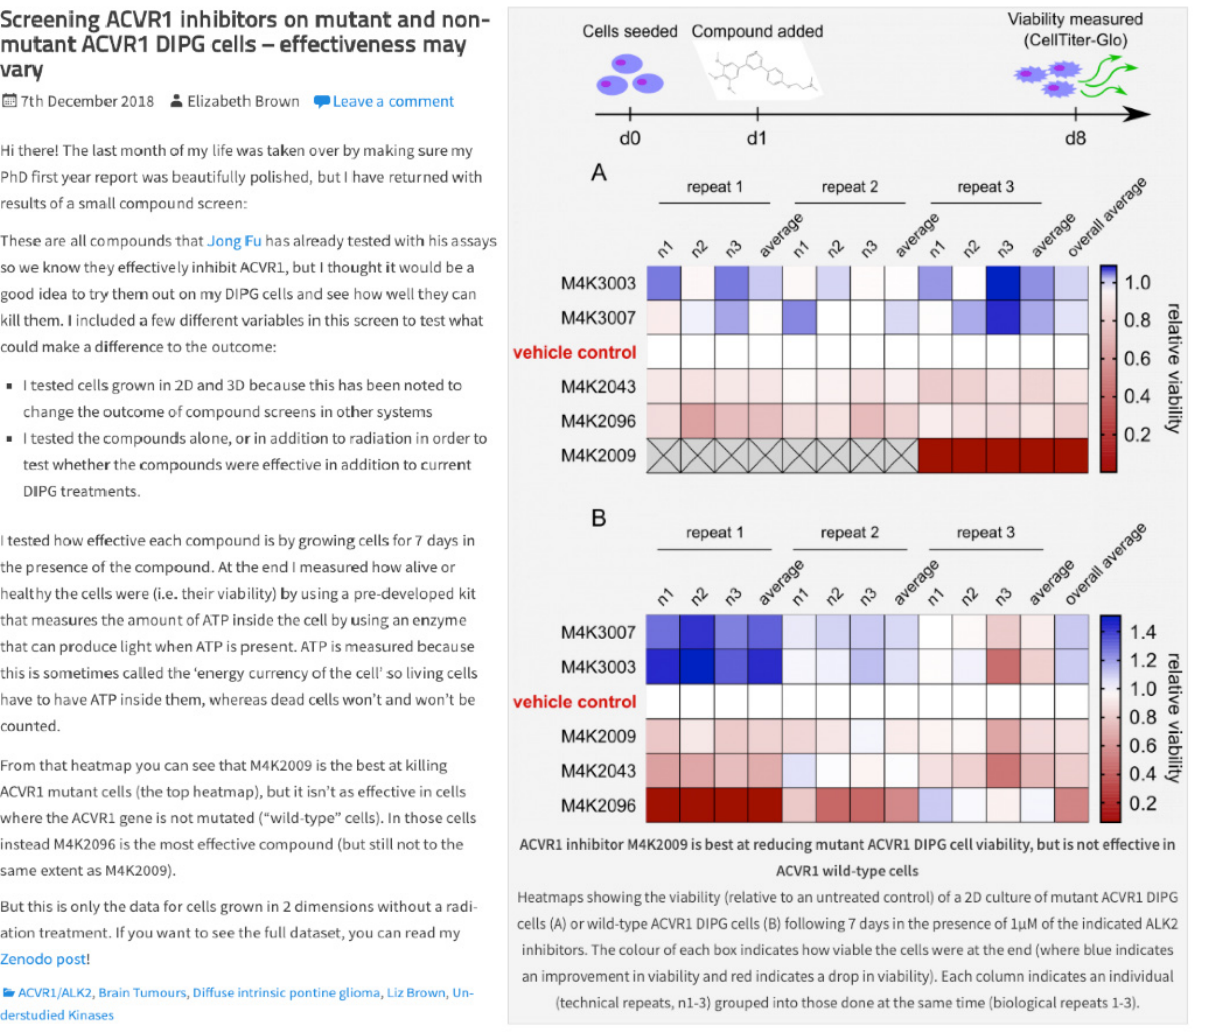
Figure 2. A blog explains in language accessible to non-scientists (such as patient groups) the rationale and take-home message of the